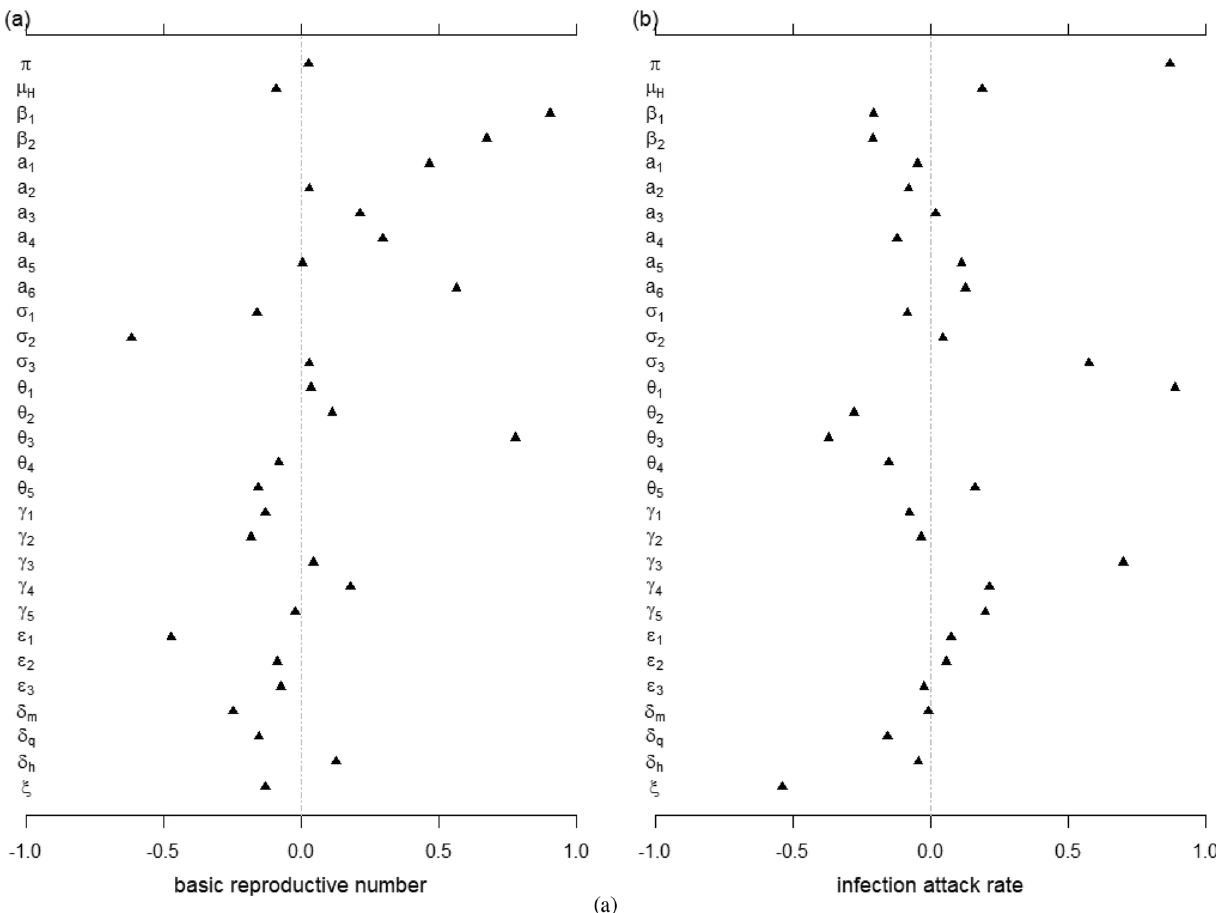
Figure 2. The partial rank correlation coefficient (PRCC) of the basic reproduction number R 0 and infection attack rate with respect to model